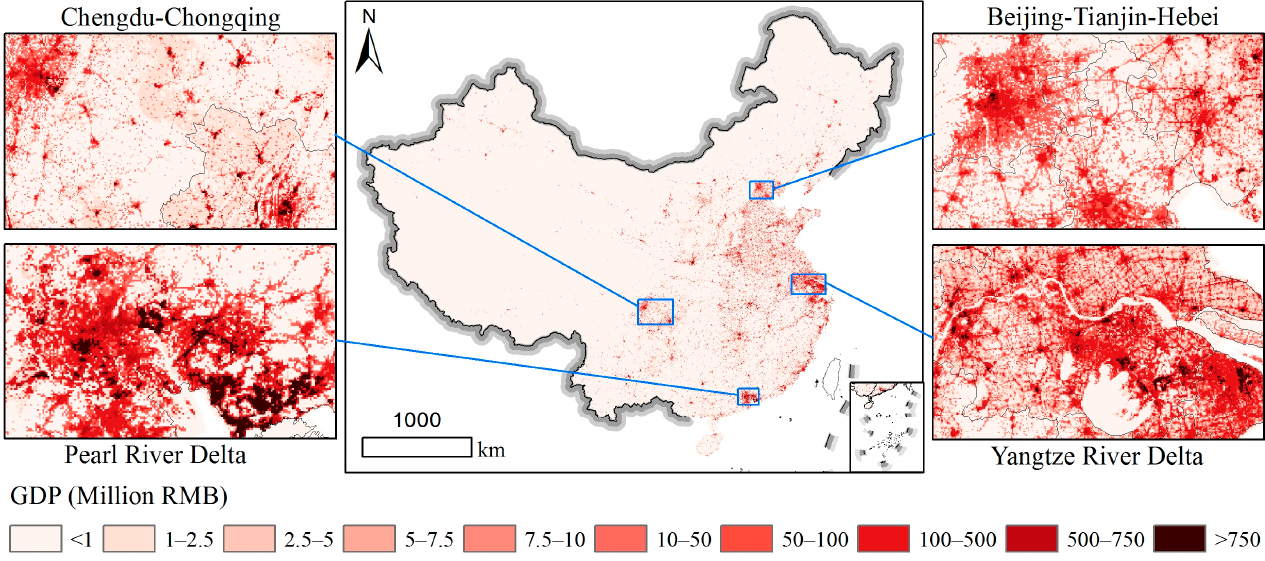
Figure 8. The 1 km gridded GDP map of China for the secondary sector.